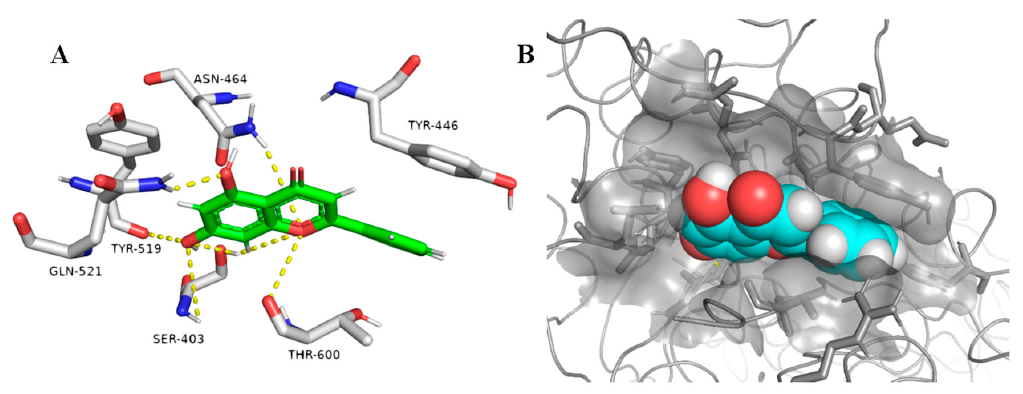
Figure 5. Binding mode of chrysin (5) inside PBP2a’s active site ( A and B ).